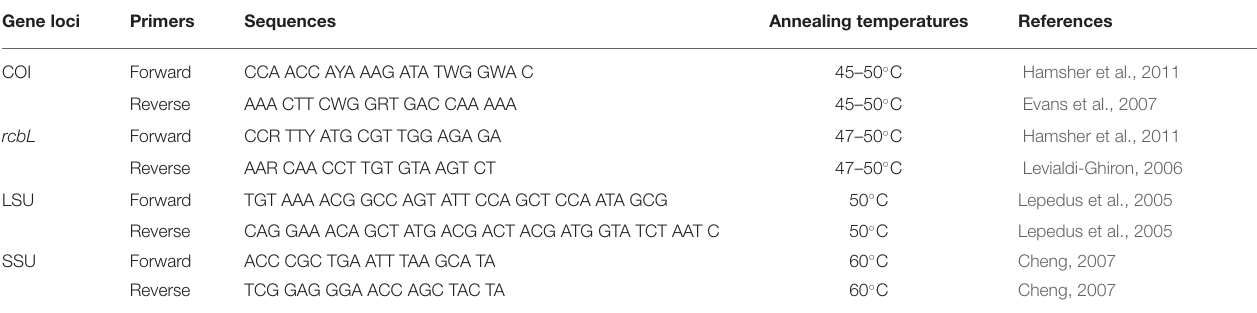
TABLE 1 | Primers for amplifying genetic